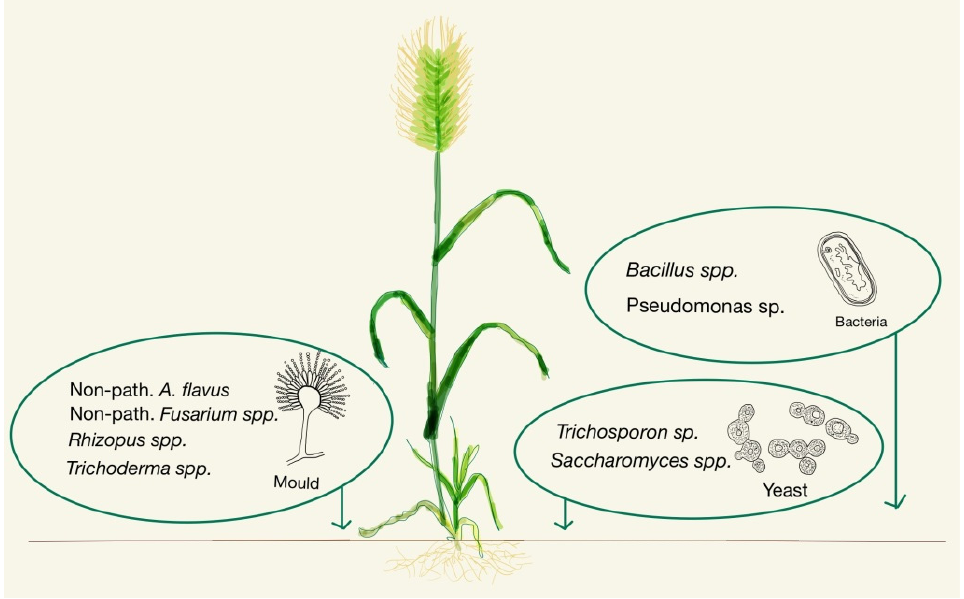
Figure 3. Bio-controlling microorganisms of use in the fields.